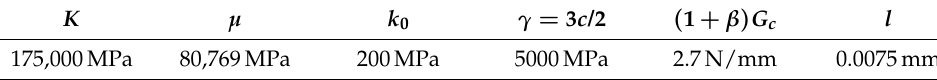
Table 1. Material parameters used in the finite element